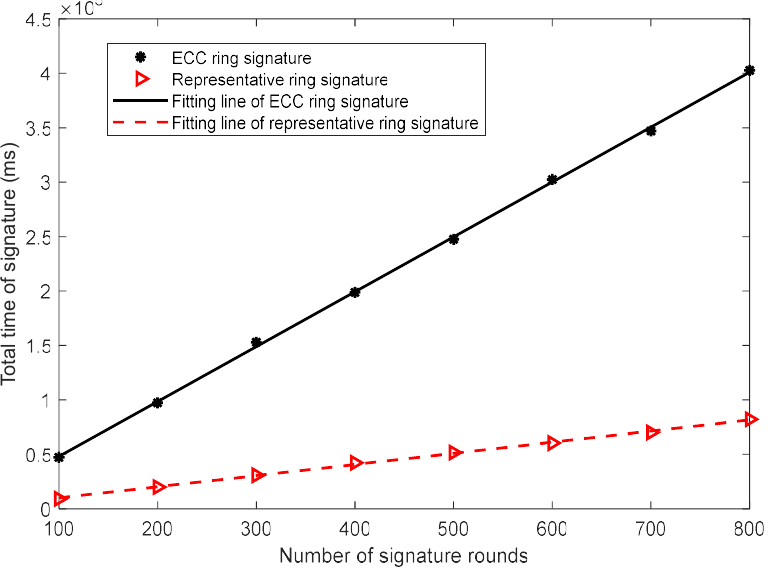
Figure 9. The total time comparison of signatures between two schemes.